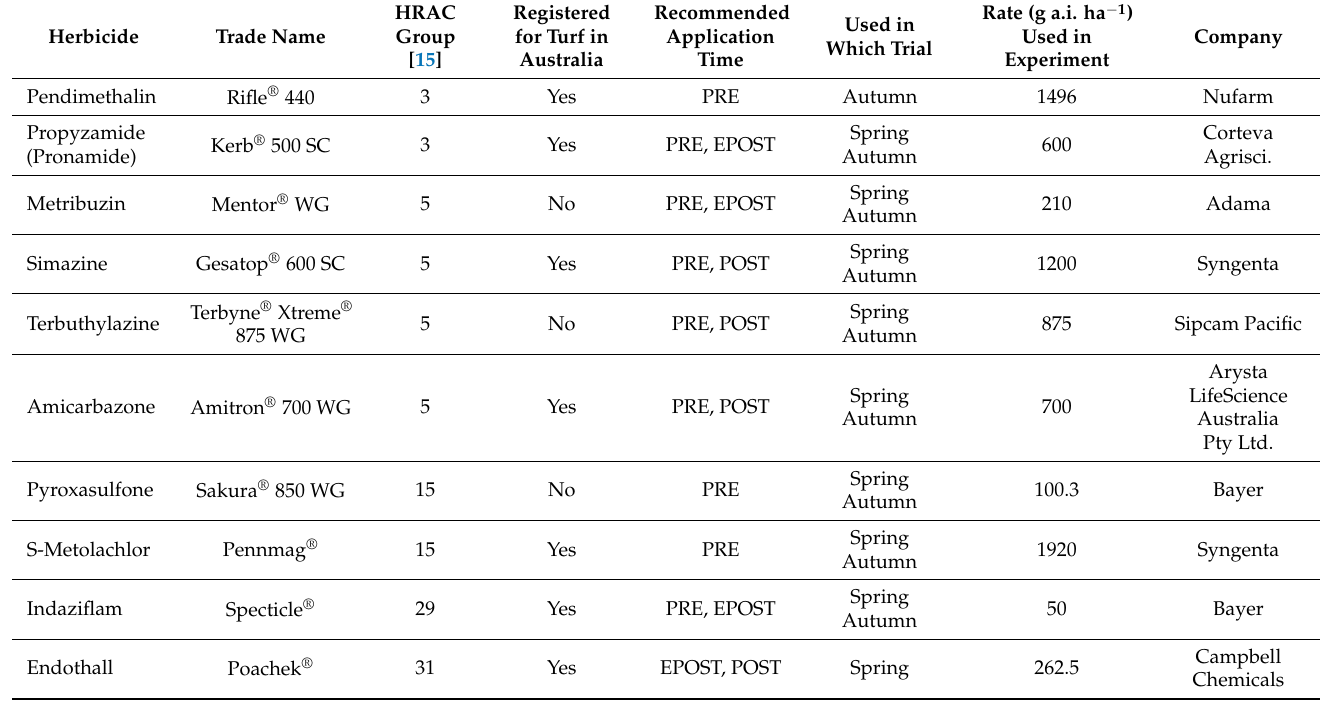
Table 3. List of herbicides used in spring and autumn